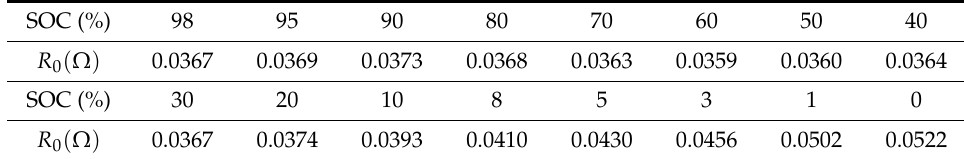
Table 5. Reference values of R 0 at different SOC levels in 25 ◦ C.